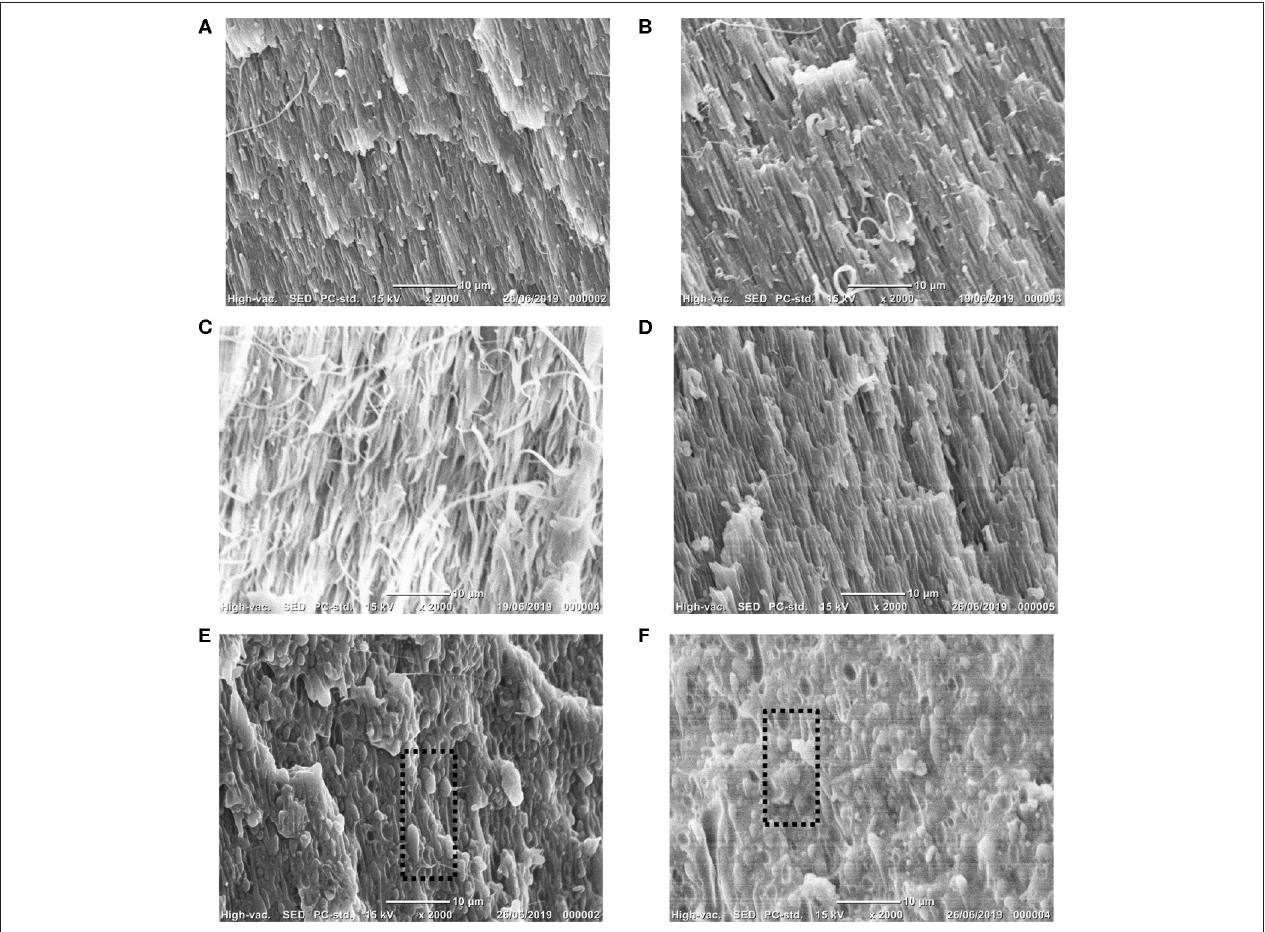
FIGURE 8 | Transversal section SEM analysis of injection-molded PLA/PA12/PLA-g-MA blends (A) 70/30/0, (B) 69/30/1, (C) 68/30/2, (D) 67/30/3, (E) 66/30/4, and (F) 65/30/5.